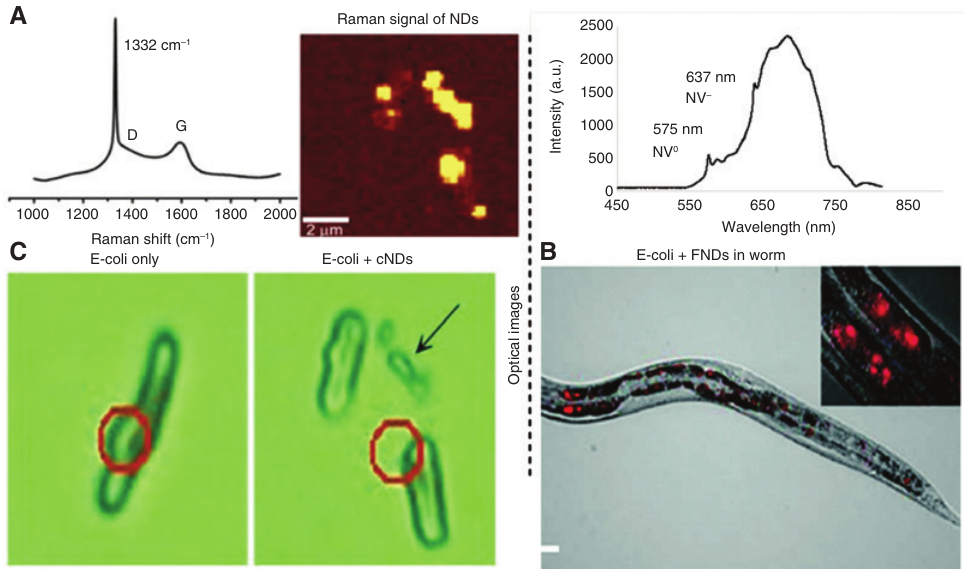
Figure 17: Diamond optical Raman and fluorescence signals for bacteria detection. (A) Raman peak of 100 nm diamond peaks at 1332 cm −1 (left). Optical Raman signal of NDs during the interaction of E. coli with cND-lysozyme complex (right). (B) NV center fluorescence of 100 nm interacted with E. coli inside a worm. Red spots are the NV luminescence in the optical image. (C) In the optical images, E. coli cells can be seen but the NDs cannot be seen beyond the diffraction limit of optical microscopes. Adapted from [47,